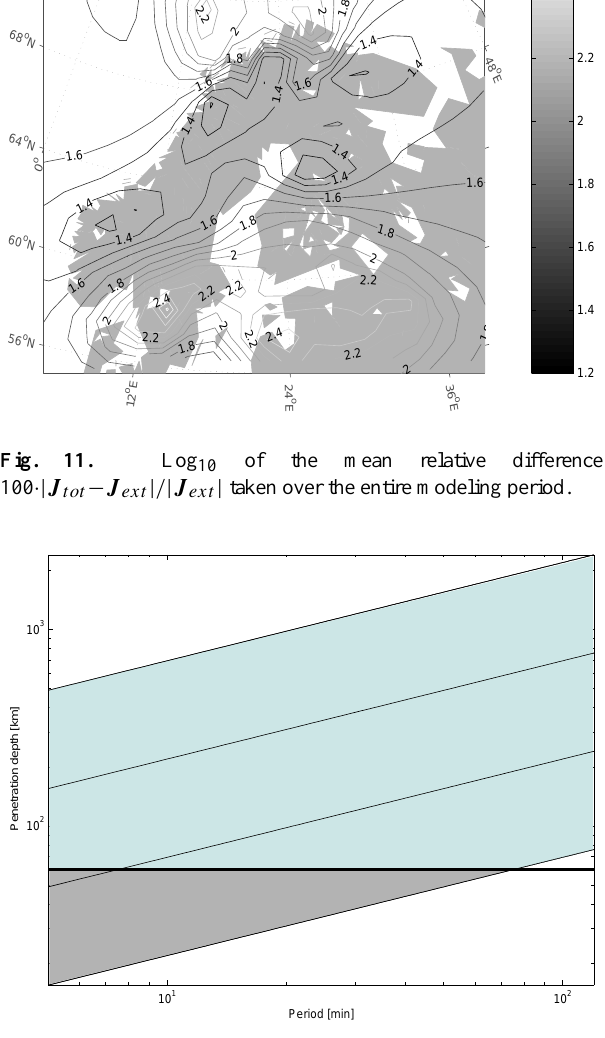
Fig. 12. Penetration depth of the periods from 5 to 120min for aver- age conductivities in Fig. 3. Thin lines correspond to conductivities 10 − 0 . 5 , 10 − 1 . 5 , 10 − 2 . 5 and 10 − 3 . 5 S/m from the bottom to the top. The thick line indicates the 60km penetration depth, i.e. the bottom of the 3-D crust used in the